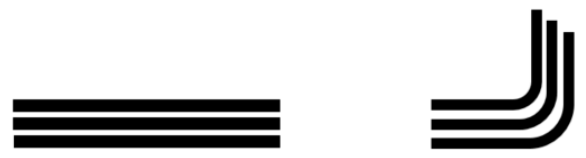
Figure 3. Interlaminar sliding caused by laminate folding.